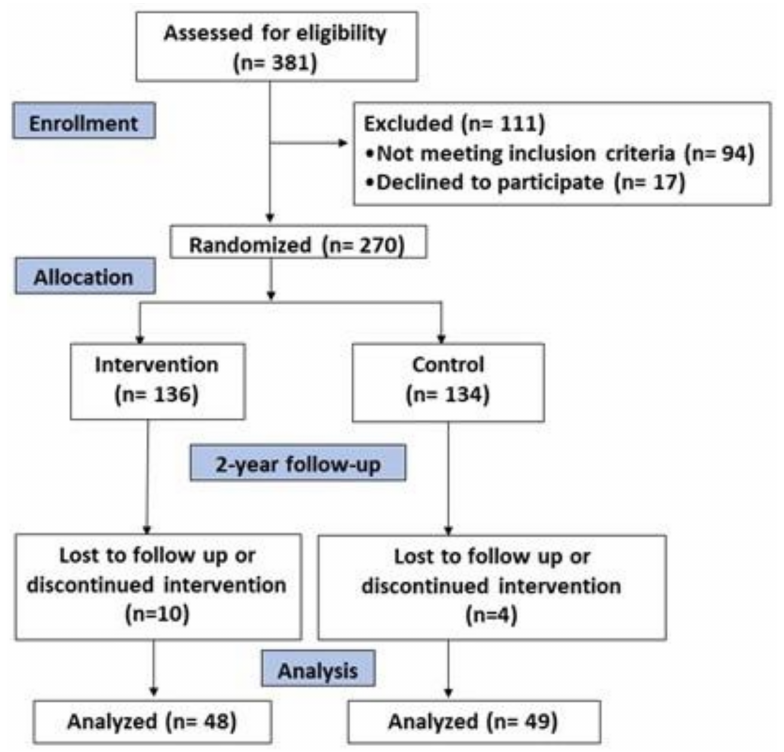
Figure 1. Flowchart of the